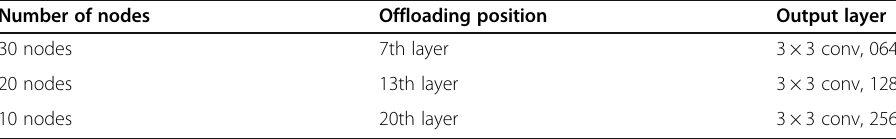
Table 1 Offloading position calculated by TMOA Number of nodes Offloading position Output layer 30 nodes 7th layer 3 × 3 conv, 064 20 nodes 13th layer 10 nodes 20th